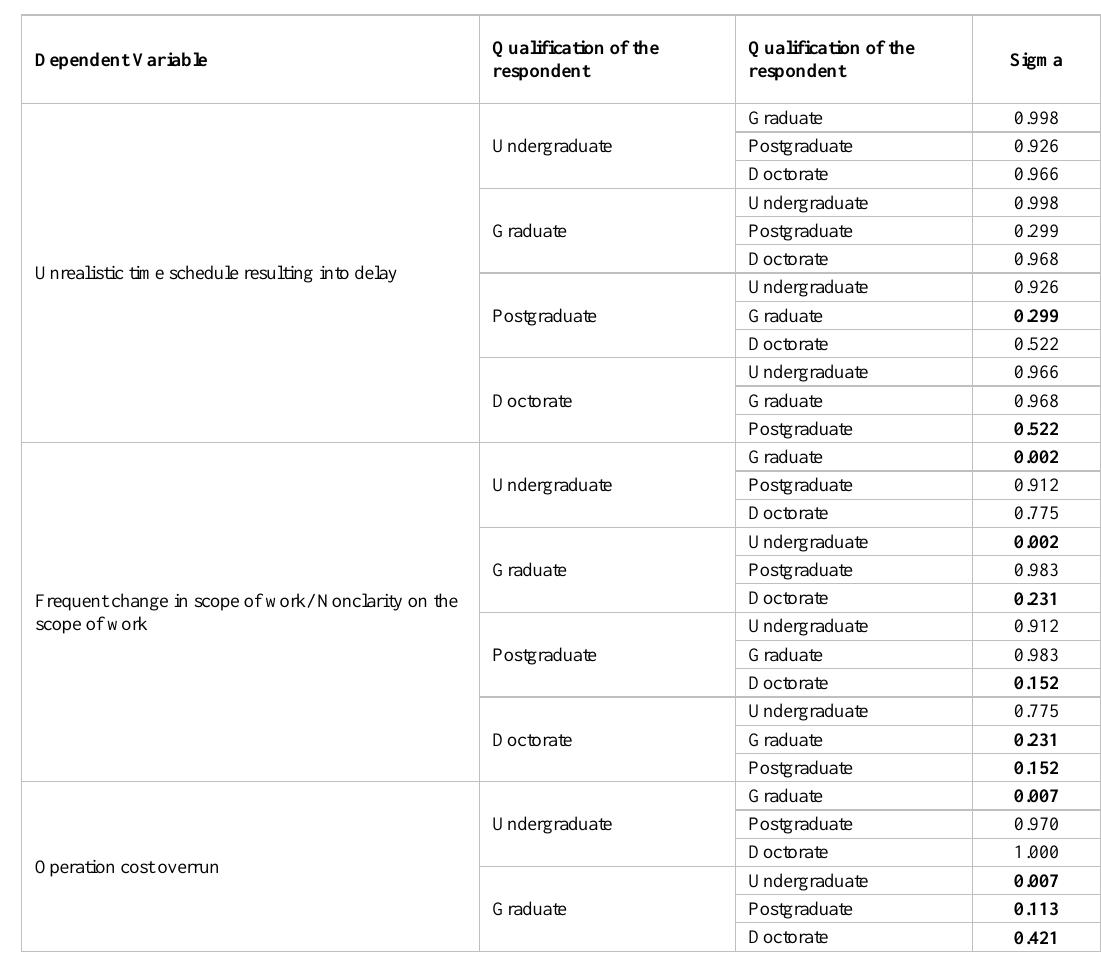
Table 4. Sigma for